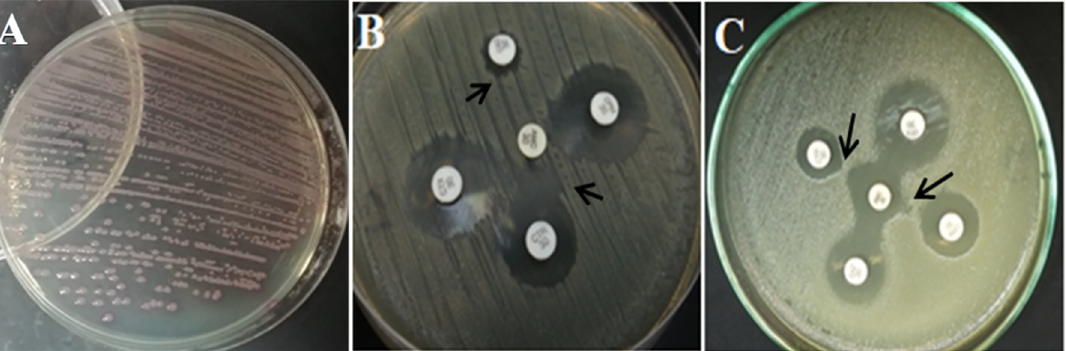
Figure 1. ( A ) E. coli on ESBL chromogenic agar. ( B , C ) Double Disc Synergy Test (DDST), which was